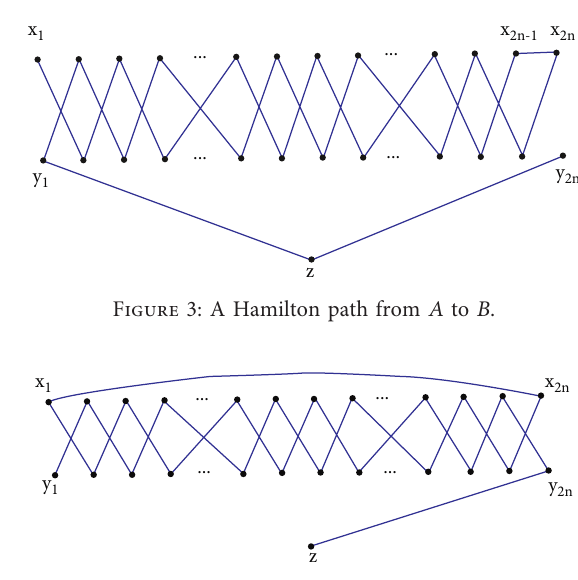
Figure 4: A Hamilton path from Y to z